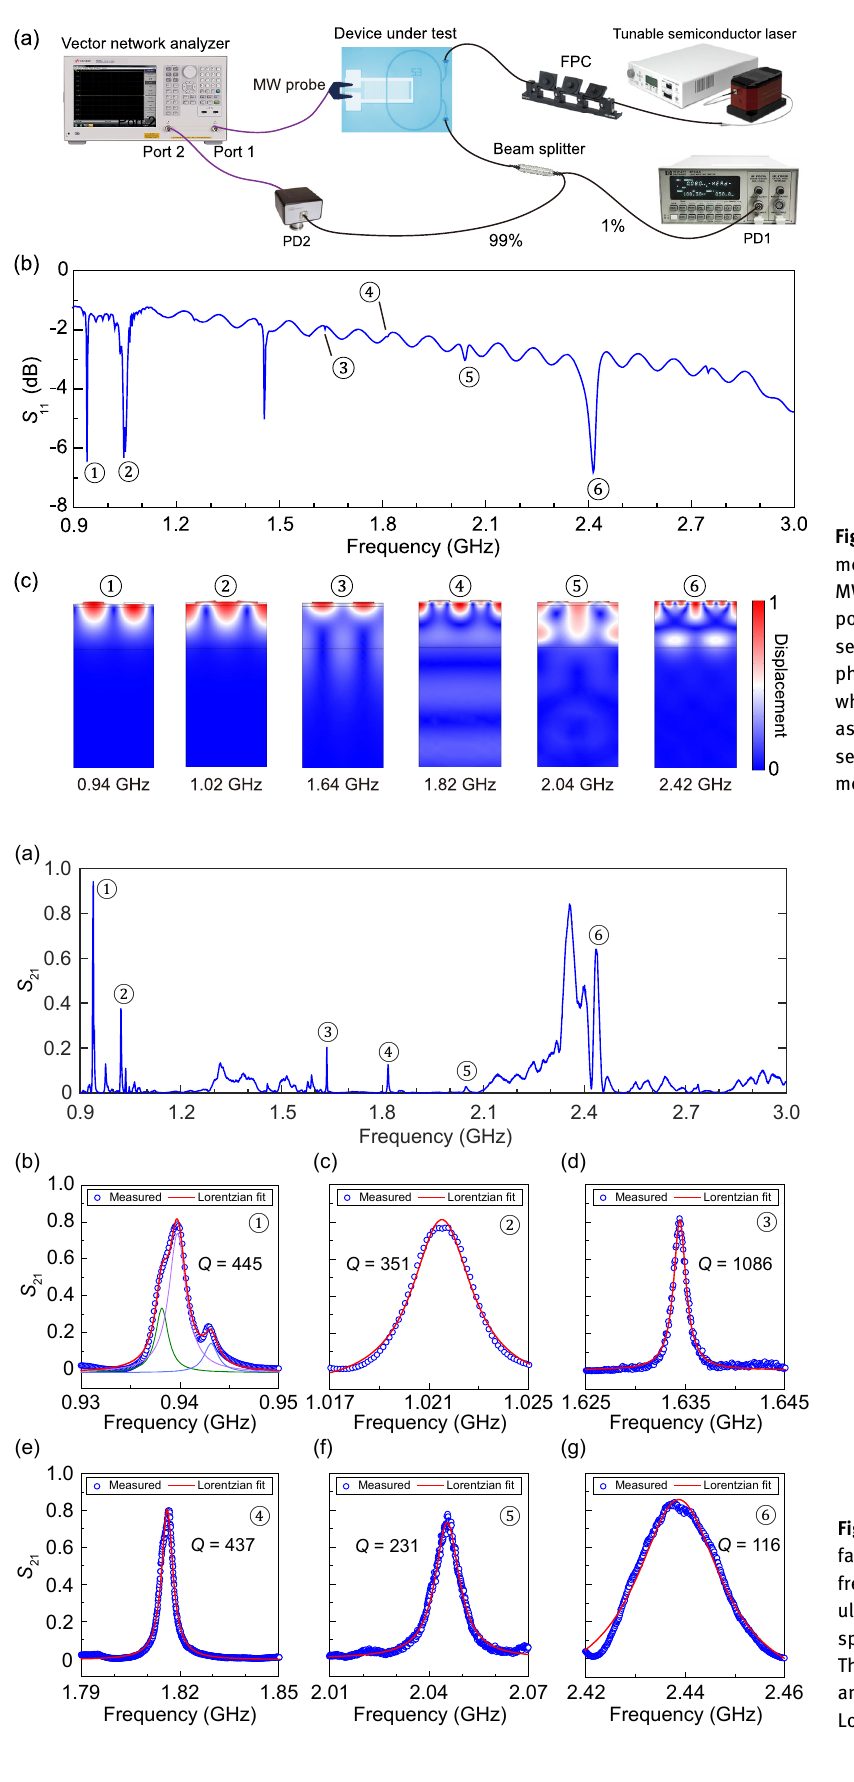
Figure 4: (a) Measured S 21 spectrum of the fabricated device, which shows the frequency response of acousto-optic mod- ulation. (b) – (g) Individual zoomed-in spectra for the SAW modes labeled in (a). The blue dots represent the measured data and the red lines are the corresponding Lorentzian fi